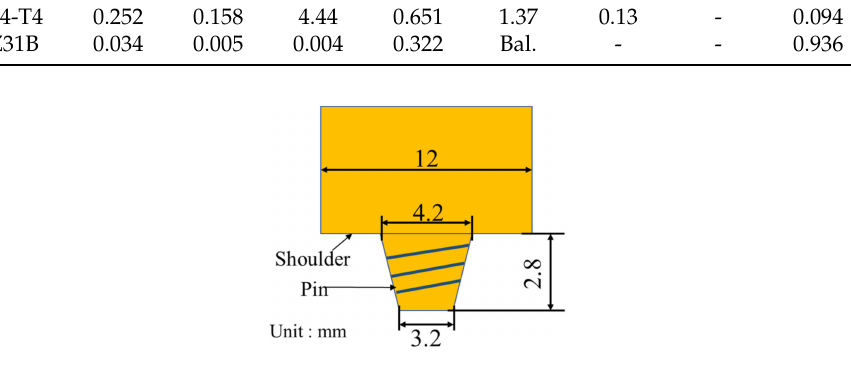
Figure 2. Schematic of FSW tool.